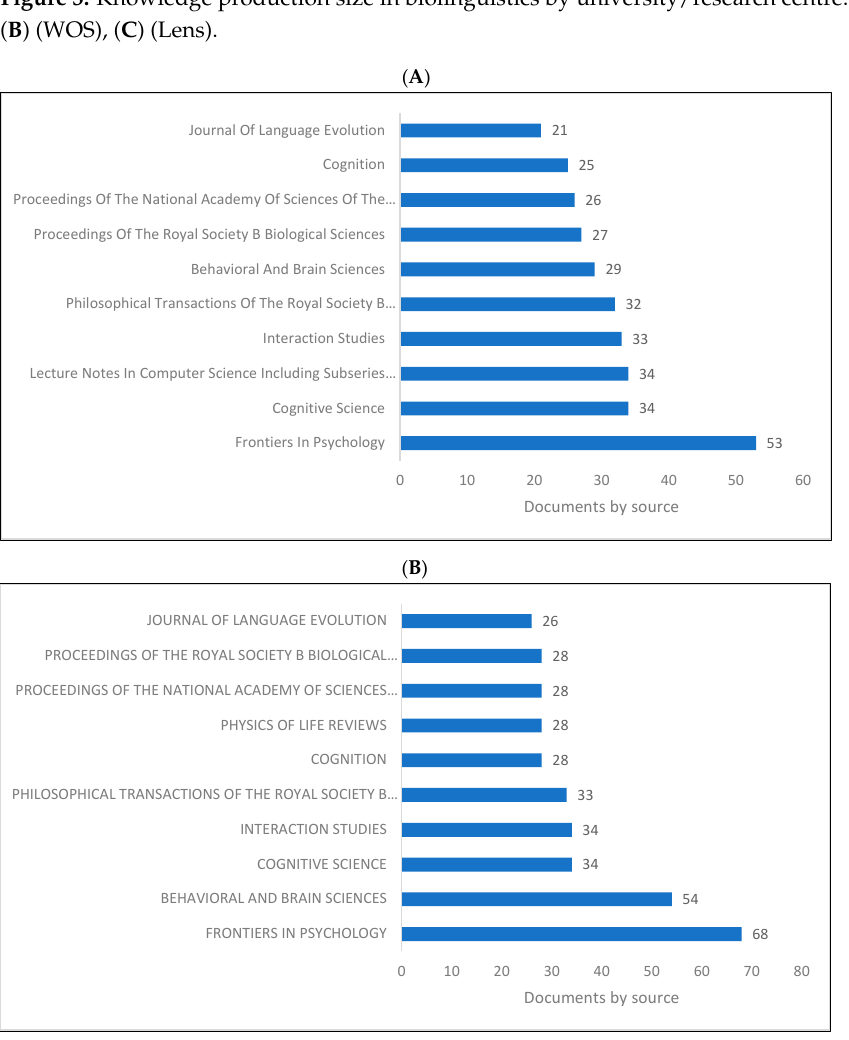
Figure 3. Knowledge production size in biolinguistics by university/research centre. ( A ) (Scopus), ( B ) (WOS), ( C ) (Lens).